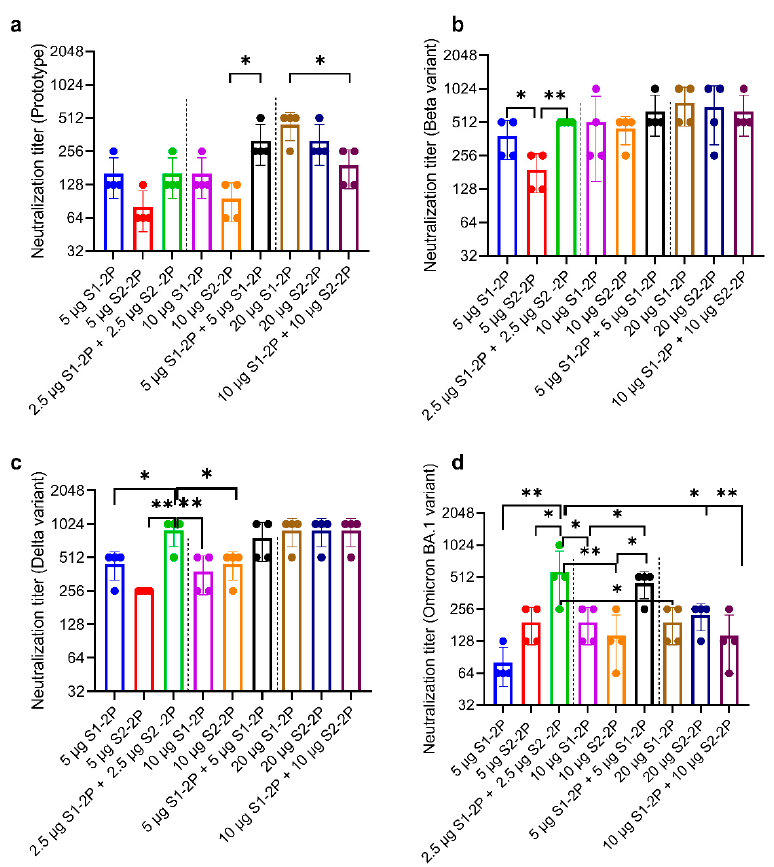
Figure 5. Analysis of neutralizing antibodies in the serum of vaccinated mice. Neutralization titers of vaccinated mouse sera against SARS-CoV-2 prototype ( a ), Beta variant ( b ), Delta variant ( c ), and Omicron variant ( d ). Live SARS-CoV-2 virus neutralization was accessed in sera of vaccinated mice collected two weeks after the third immunization. The dots of different colors represented mouse serum of different immune groups. The data were represented as the reciprocal of the serum dilution that protected Vero-E6 cells from CPE compared with no serum control. Statistically significant differences were compared using one-way ANOVA or t -test and are indicated as * for p < 0.05 and ** for p < 0.01 .